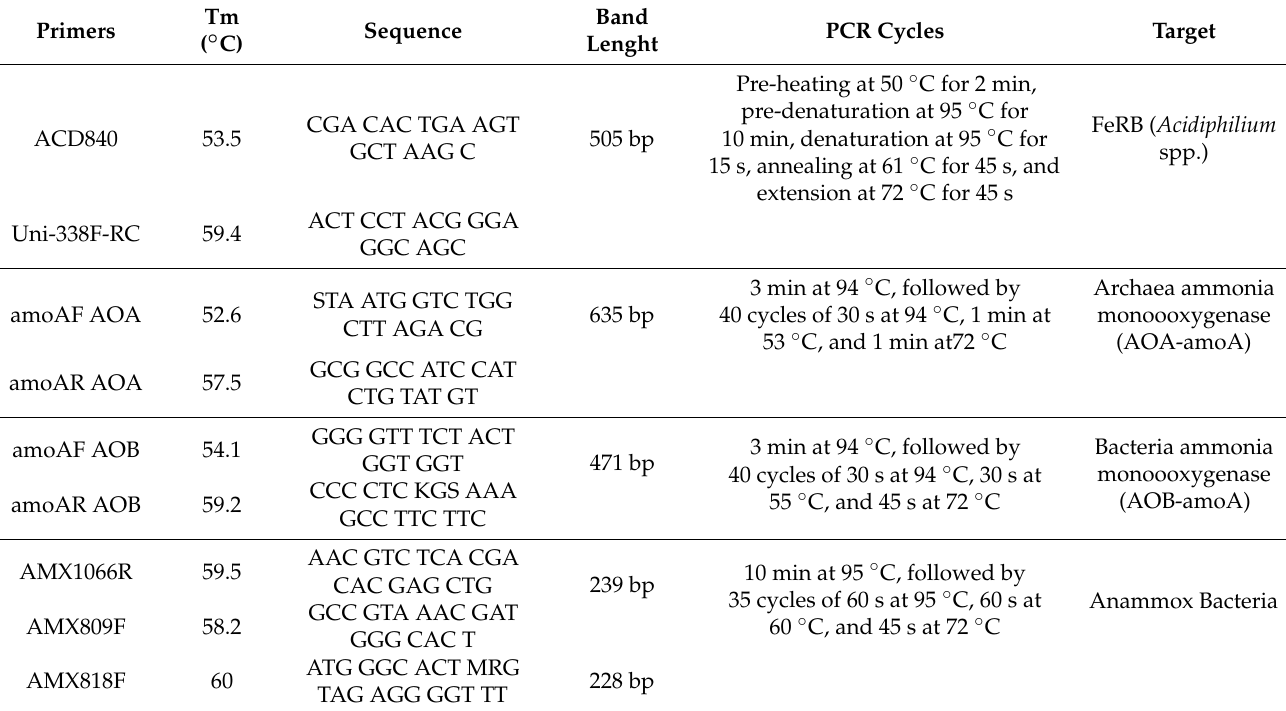
Table A1. Primer sets, characteristics, and PCR